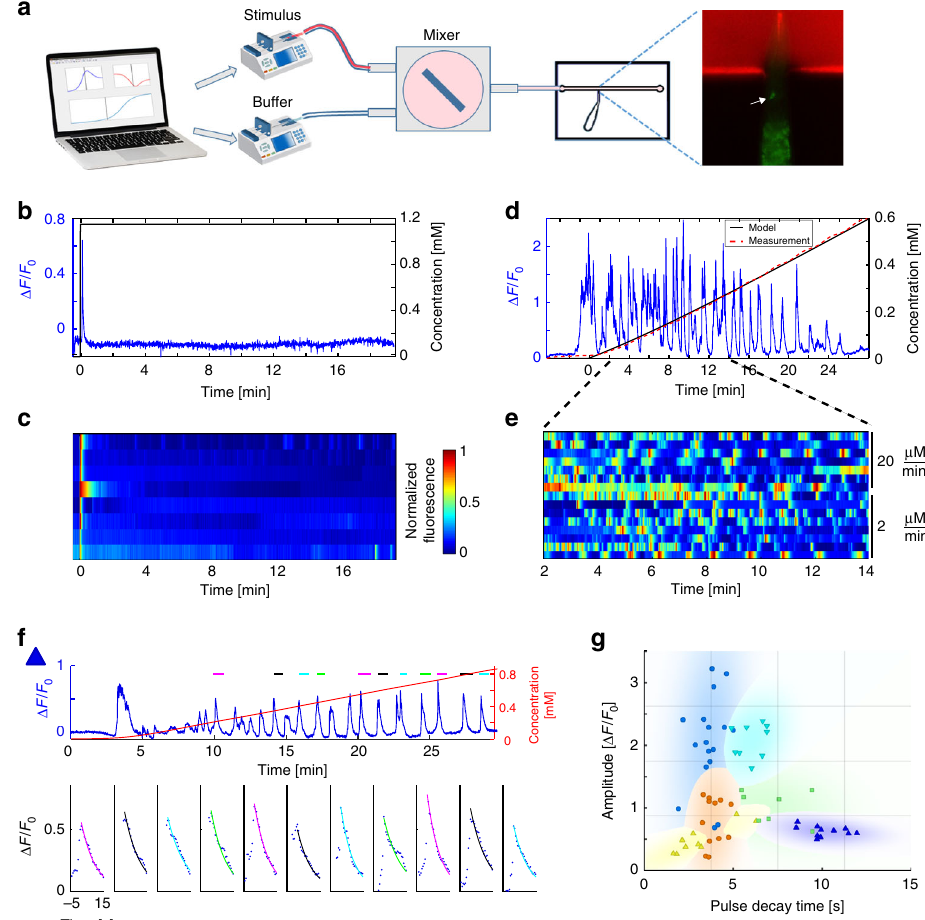
Fig. 1 Smooth increasing gradients are coded by a pulsatile activity. a Illustration of the experimental setup. Two computer-controlled syringe pumps fl ow the stimulus (diacetyl with red dye, top) and the buffer (bottom) into a mixing chamber. The homogenous stirred mixture fl ows through a restrained worm inside a micro fl uidic device. GCaMP (green) and rhodamine dye (red) intensities are imaged. The right panel shows the restrained worm inside the chip, with the red dye in the fl ow channel. The white arrow points to the AWA neuron. b A step function of diacetyl (black) results in a single pulse. c AWA activity in response to a step function of diacetyl ( N = 8). The fi rst row depicts the dynamic response shown in b . d AWA shows pulsatile activity (blue) in response to a linear gradient of diacetyl. Shown is a sample trace of a single animal. The system outputs accurate smooth gradients, as evident by